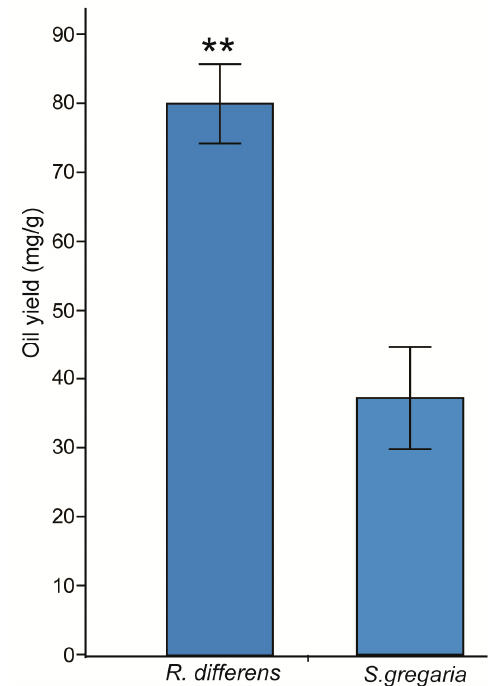
Figure 1. Bar chart showing the variation of oil yield between R. differens and S. gregaria . Error bars indicate the standard error of the mean. Asterisks indicate significant difference between the means: ** p < 0.01.